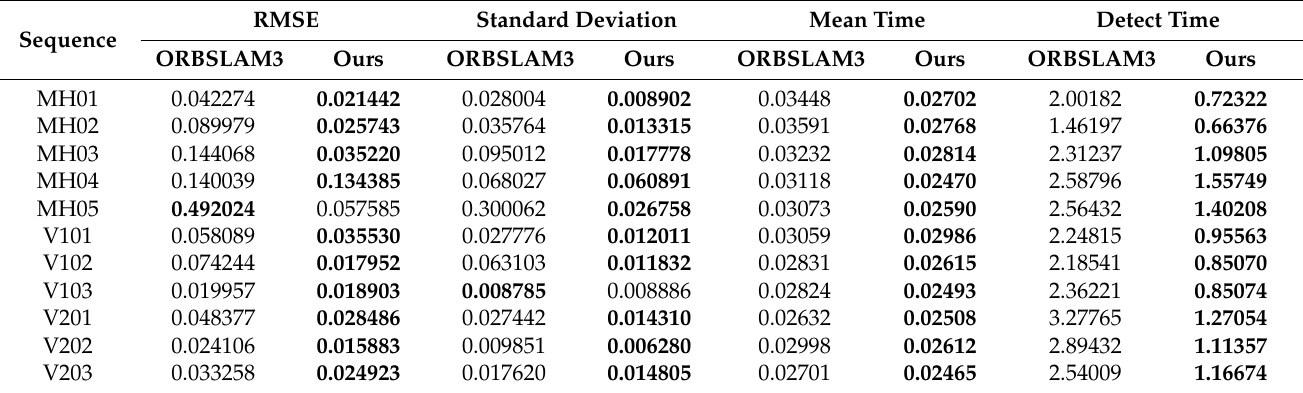
Table 2. Comparison of absolute trajectory error (ATE) and time efficiency. The mean time (unit in second) is the time consumed by tracking each frame, and the detection time (unit in millisecond) is the time consumed by each frame in the loop closure detection.